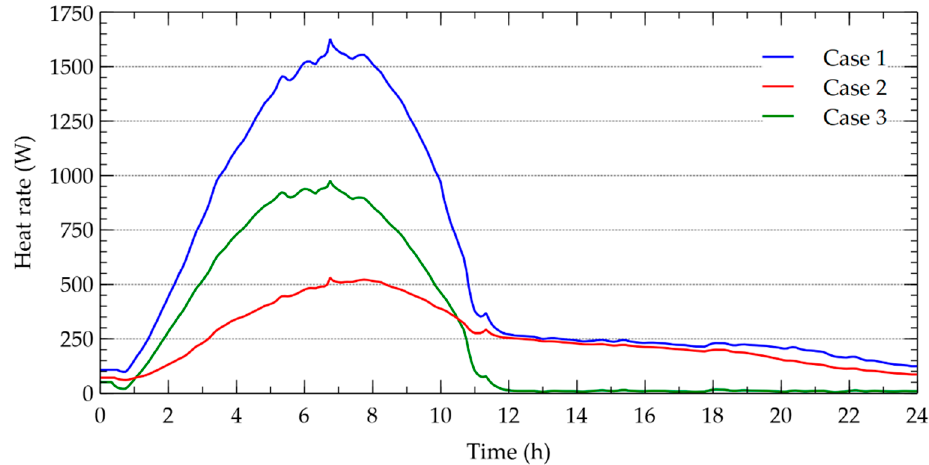
Figure 14. Estimated total losses. Energies 2020 , 13 , x FOR PEER REVIEW